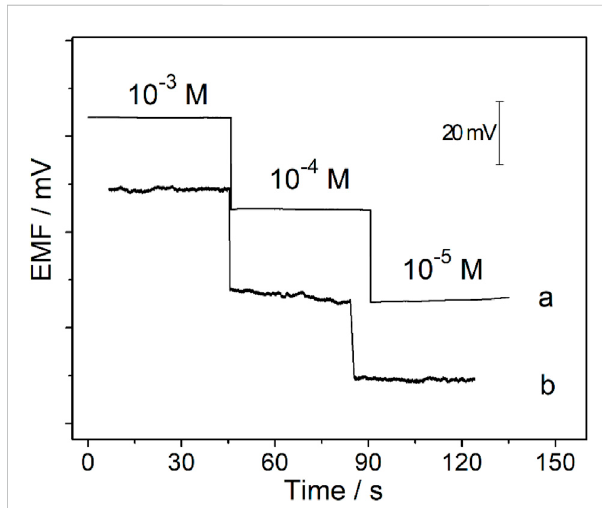
FIGURE 6 Potential responses of theCa 2+ -IS μ E recordedinCaCl 2 solutions ranging from 1 × 10 − 5 to 1 × 10 − 3 M through the CHI660E electrochemical station (a) and the patch clamp (b).